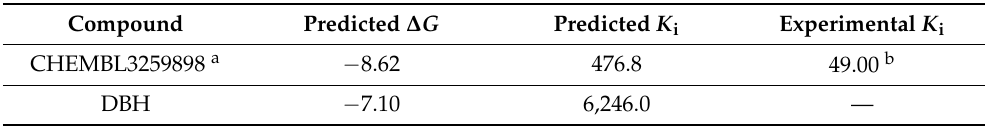
Table 3. Predicted free energies of binding ( ∆ G , kcal/mol) and inhibition constant ( K i , nM) for the HIV integrase receptor.